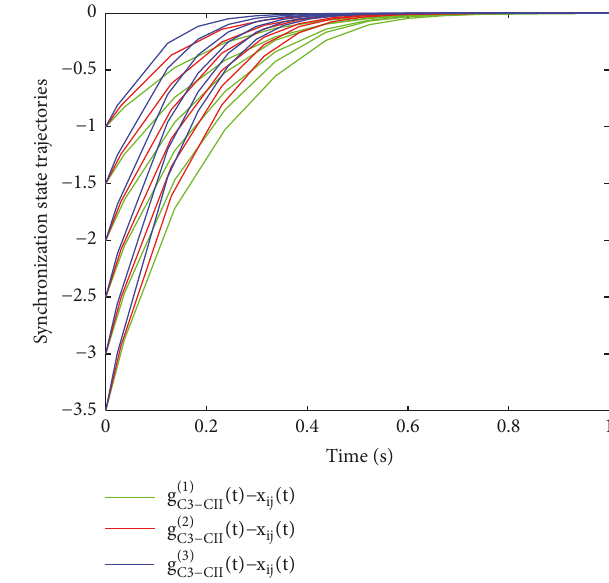
Figure 3: Synchronization state trajectories of the network (36) for the case II of Corollary 20.